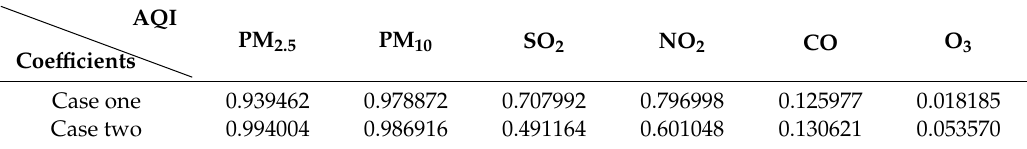
Figure 4. The correlation relationship between AQI and six pollutants in case two. Table 2. The correlation coefficients between AQI and six pollutants.